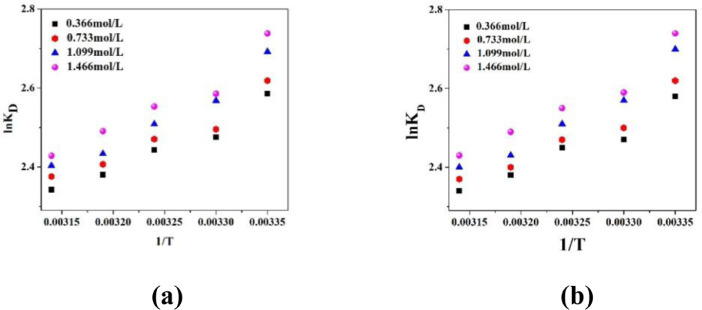
Variation of lnKD with 1/Tusing (a) Sunflower oil and (b) Soybean oilas diluents. TBP concentration is varied in the range of 0.366 to 1.466 mol/L.